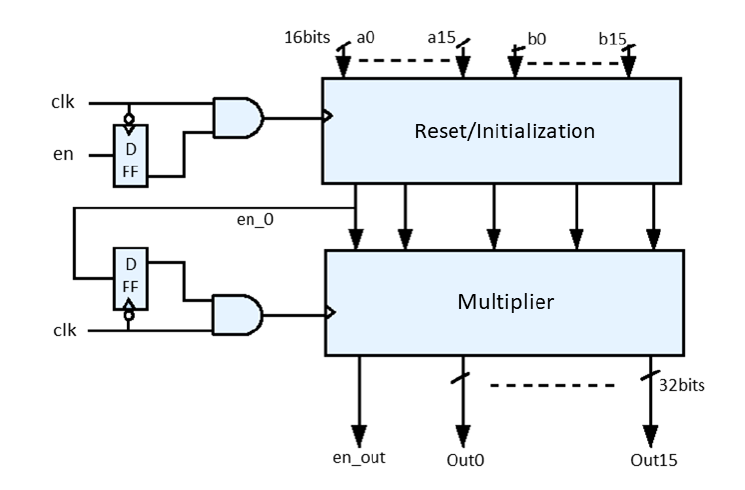
Figure 8. Applied local explicit clock gating (LECG) to the multiplier for